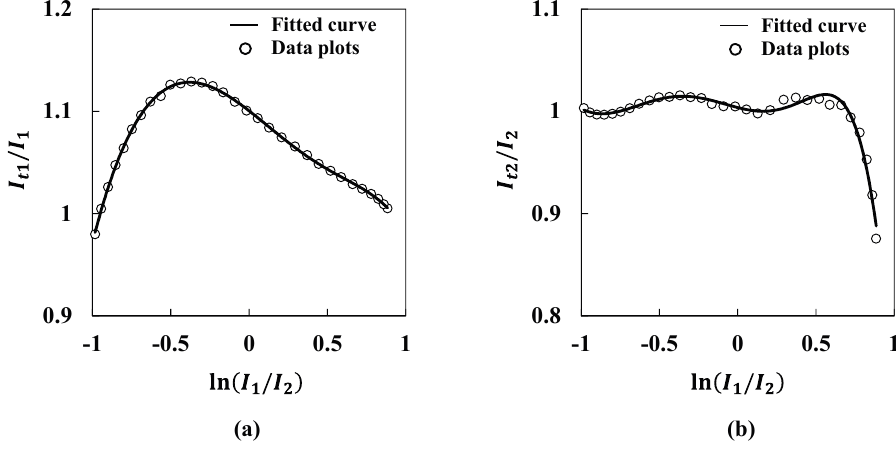
Figure 8. Derivation of compensation coefficients ( a ) e 1 and ( b ) e 2